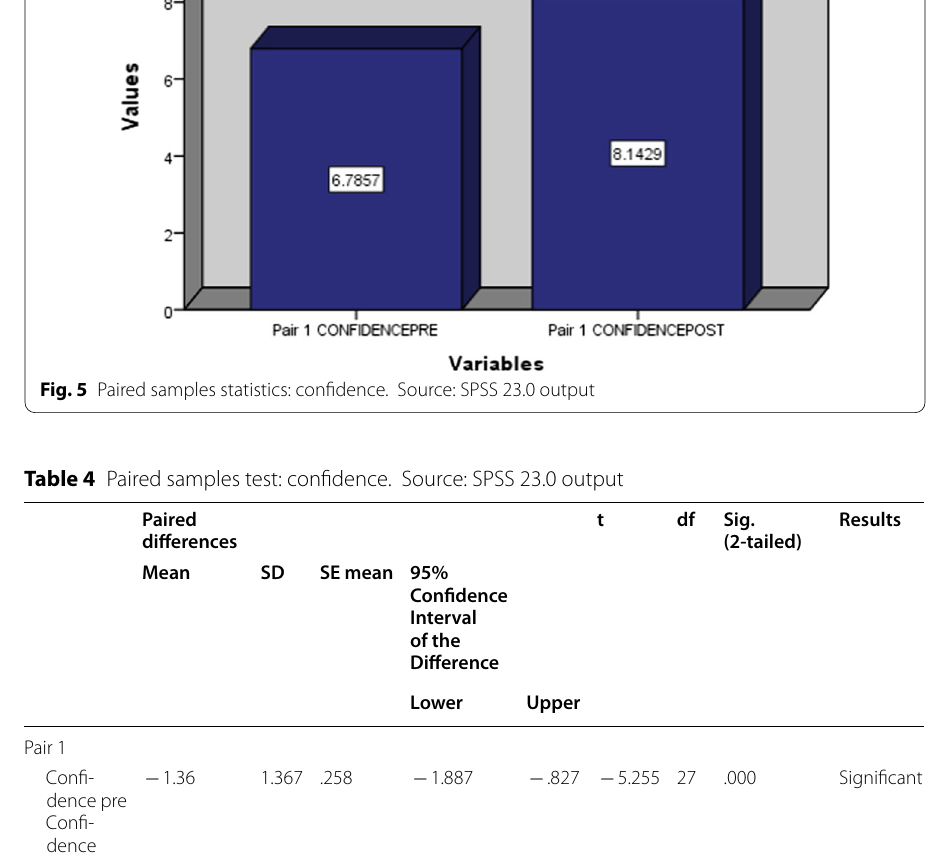
Table 5 Paired samples statistics: concentration. Source: SPSS 23.0 output Mean N SD SE mean Pair 1 Concentration pre 6.43 28 1.709 .323 Concentration post 7.79 1.729